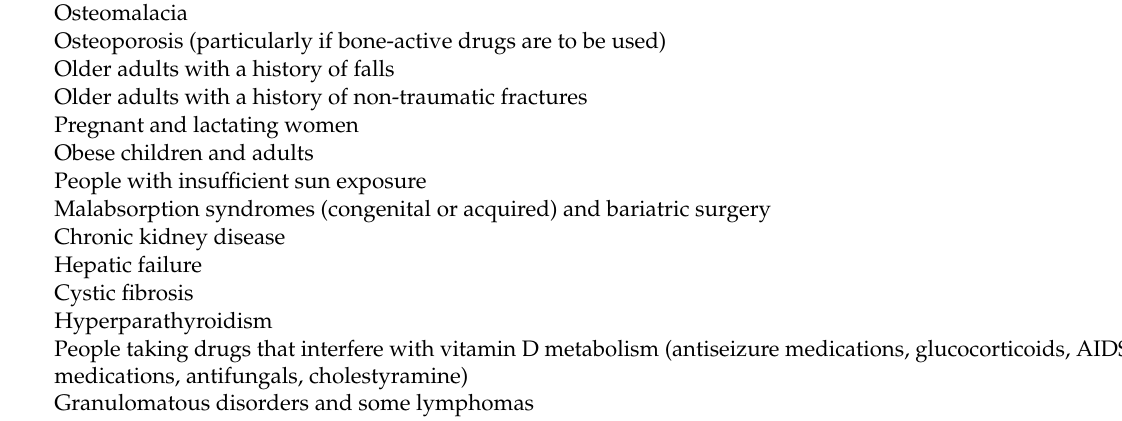
Table 2. Categories of patients that should be screened for vitamin D